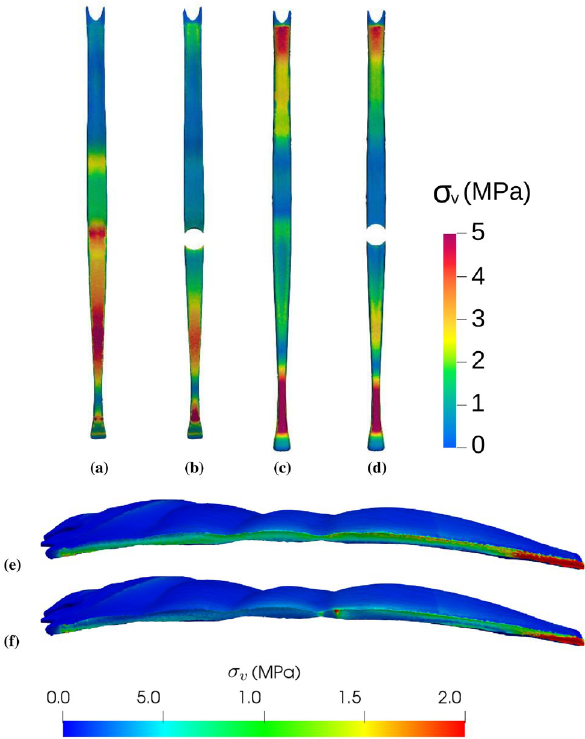
Figure 4. Distribution of Von Mises tension ( σ v ) on the anterior ( a , b ) and posterior ( c , d ) surfaces of the linea alba and ( e , f ) on the inner lateral region of the left rectus abdominis muscle (the surface that is in contact with the LA). ( a , c , e ) Reference case (model without incisions). ( b , d , f ) Case with a stoma located on the linea alba ( s 0 ). Note that in parts ( e ) and ( f ) the axes are rotated so that the leftmost region of the RA here corresponds to the uppermost RA region in Fig.